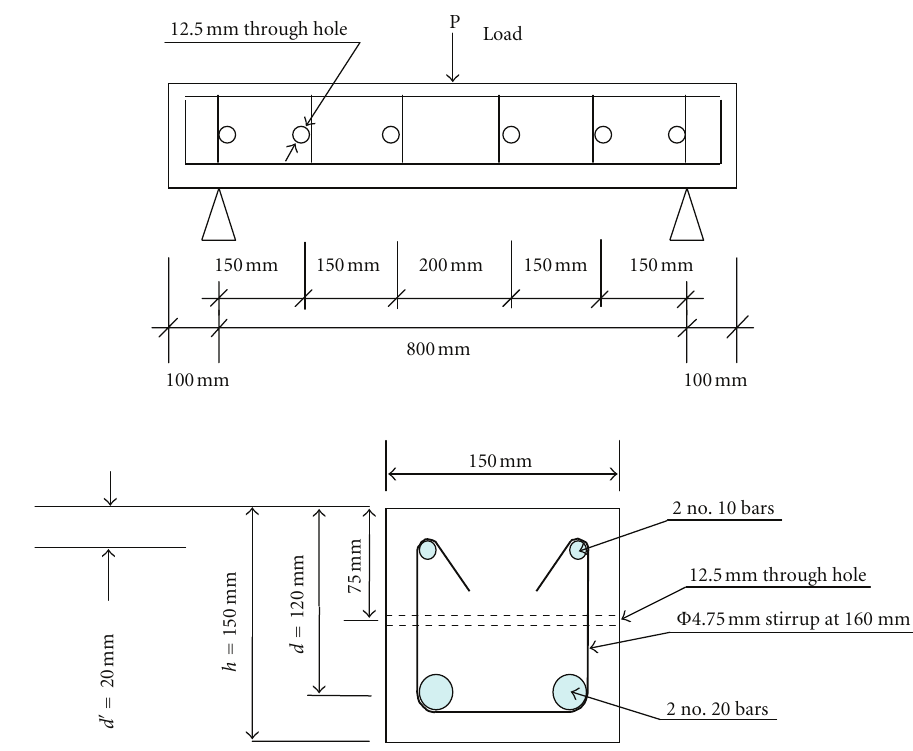
Figure 7: Cross-sectional details of RC beam C-S-6H.